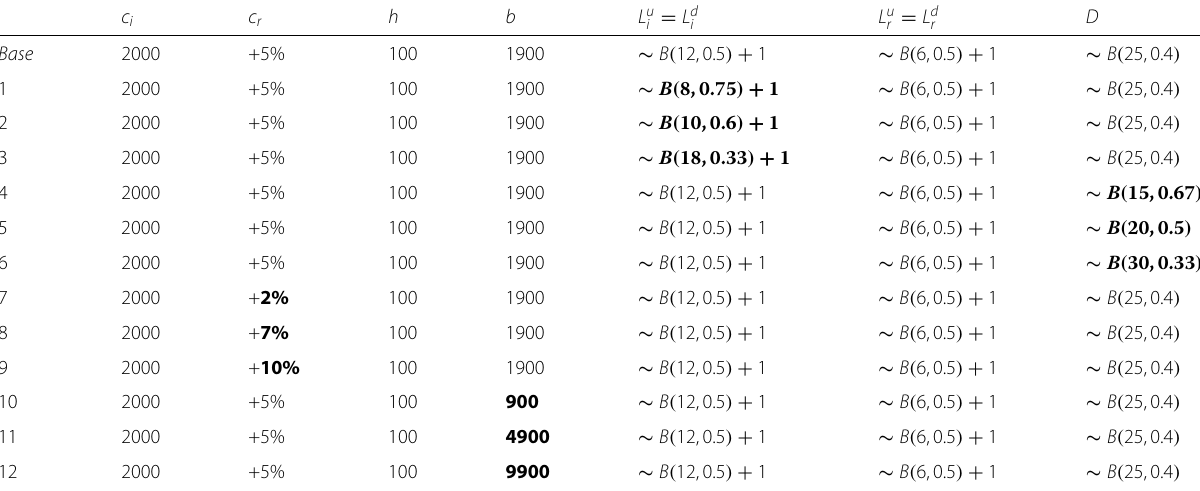
Table 2 Numerical parameters used in our simulation study. The numerical parameters that were altered for the sensitivity analysis are marked in